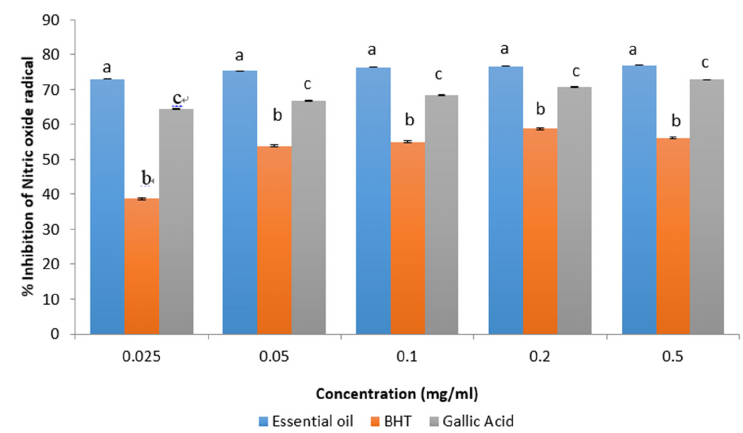
Figure 4. Nitric oxide radical scavenging activity of the essential oil of H. africana . Bar graphs with different letters within the same concentration are significantly different ( p < 0.05).